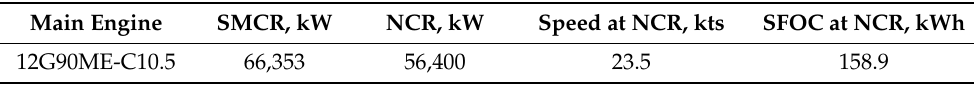
Table 3. Specification of the main engine